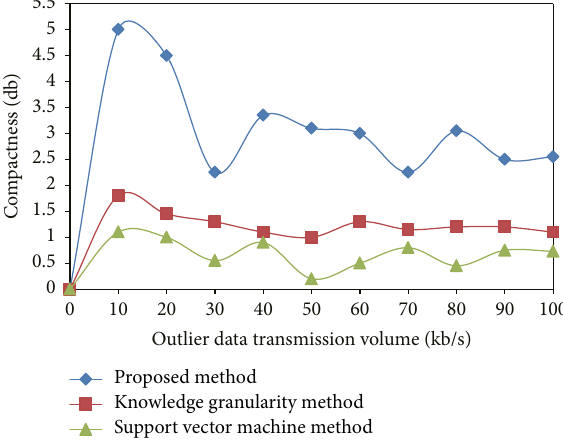
Figure 9: Cloud picture comparison of outlier data mining in information flows of a large real-time database.